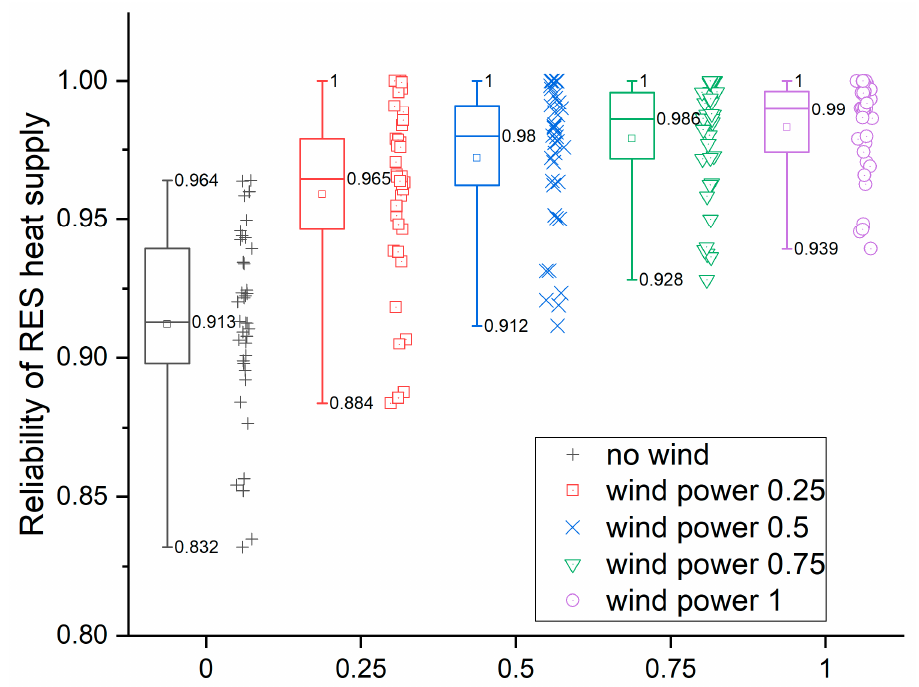
Figure 5. Reliability of energy supply from renewable energy sources depending on the size of the wind power farm. The system consisting of heat storage of 6 units capacity and a geothermal heat source of 0.5 unit capacity. Units used in the graph are extensively explained in Appendix A.